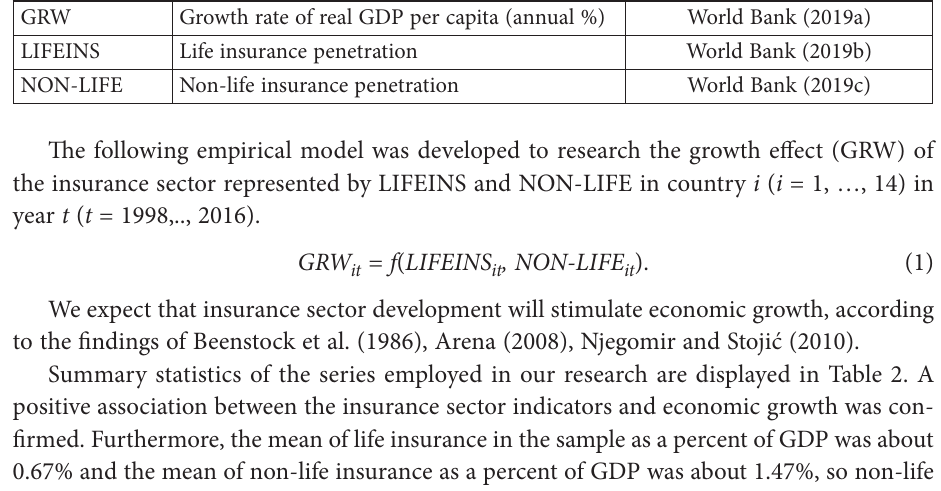
Table 1. Description of variables (source: own processing) Symbol Variables Source GRW Growth rate of real GDP per capita (annual %) World Bank (2019a) LIFEINS Life insurance penetration NON-LIFE Non-life insurance penetration